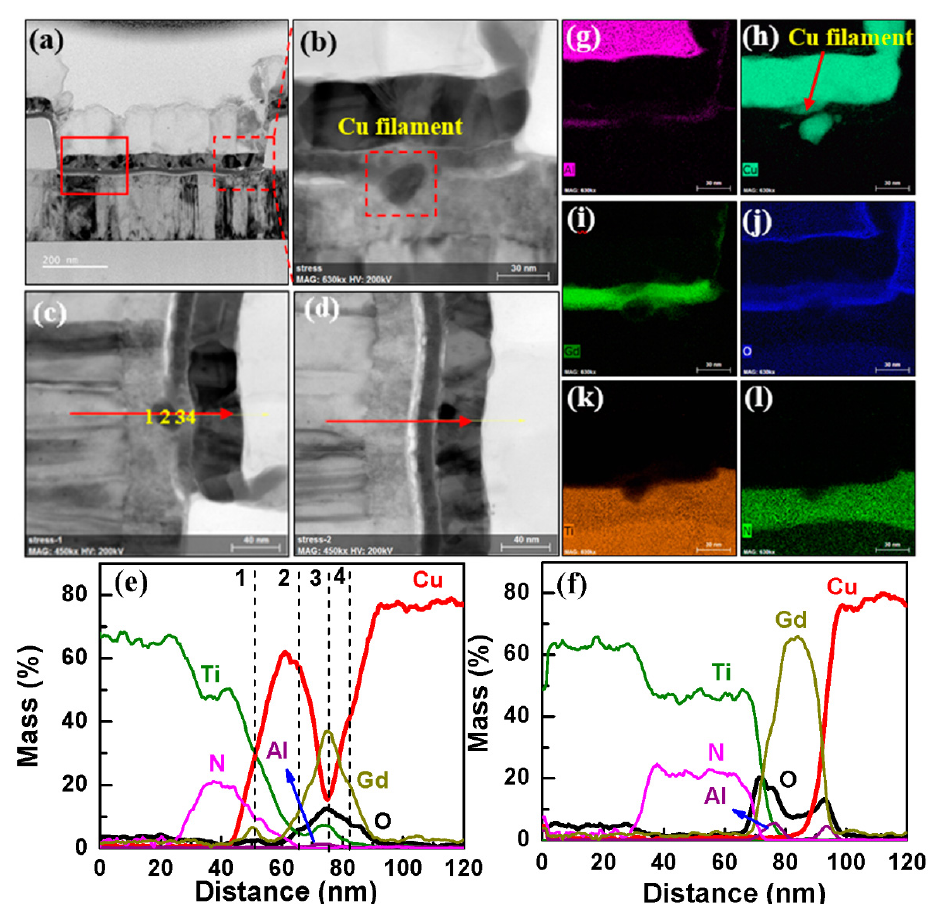
Figure 5. TEM images, EDS depth profile, and elemental mapping of the S2 devices after SET. TEM image of ( a ) 0.6 × 0.6 µm sized S2 device and ( b ) Cu filament. STEM images of ( c ) with Cu filament and ( d ) without Cu filament regions are also shown. Elemental depth profiles are measured from Ti to Cu, ( e ) with Cu filament and ( f ) without Cu filament regions. Color mapping images of ( g ) Al, ( h ) Cu, ( i ) Gd, ( j ) O, ( k ) Ti, and ( l ) N elements.